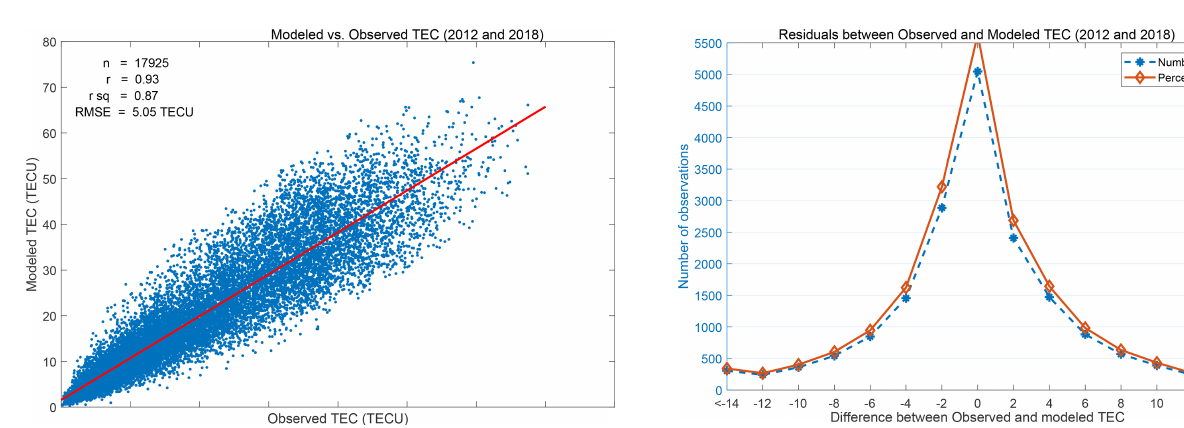
Figure 4. Scatter plot of observed TEC against modeled TEC. Figure 5. The blue and red curves show the distribution of the num- ber of observed errors (difference between observed and modeled TEC) and the percentage of the errors,